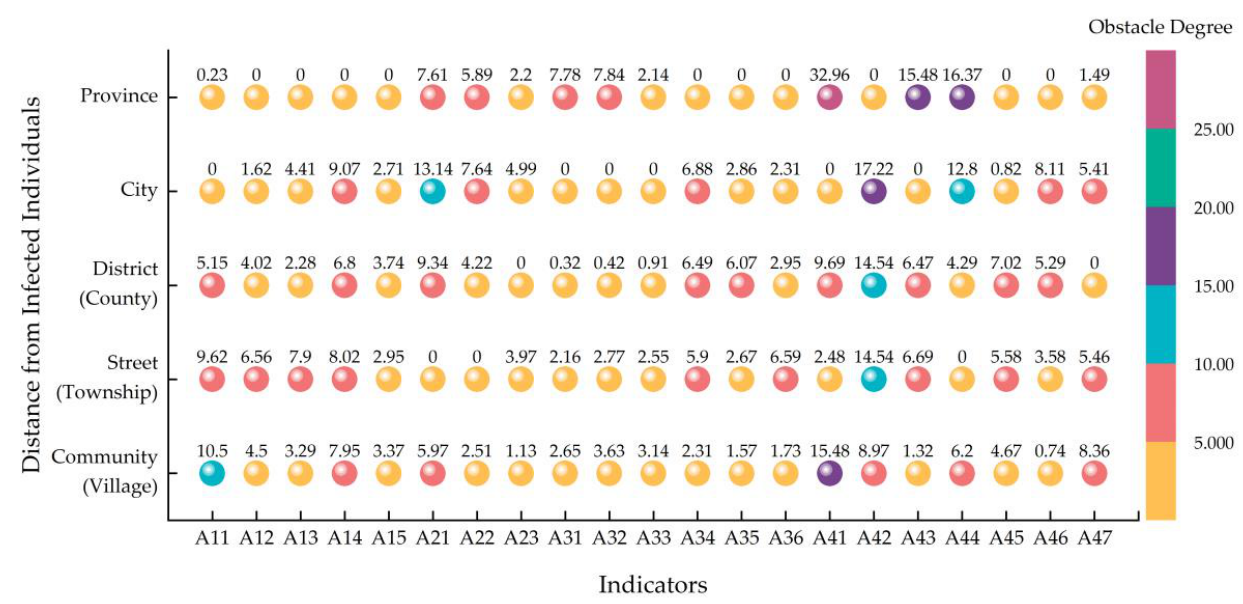
Figure 13. The main obstacle factors of safety culture among residents for different